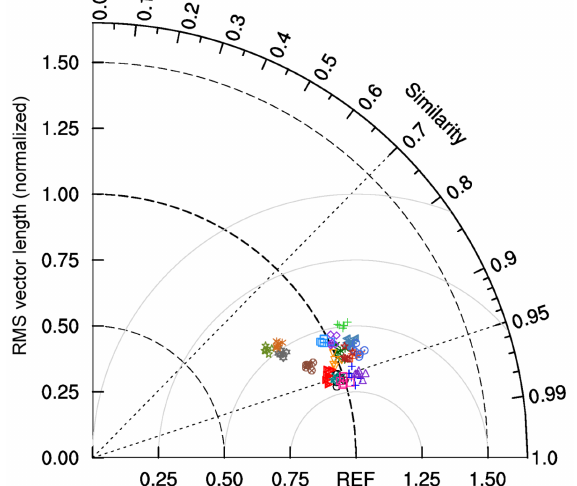
Figure 8. Normalized pattern statistics for climatological mean 850hPa vector winds over the Asian–Australian monsoon region (10 ◦ S–40 ◦ N, 40–140 ◦ E) in summer (June–July–August) derived from each independent ensemble member by models 12, 13, and 14. The datasets used and regridding method are the same as those in Fig. 6, except only three models are included here. Models 12, 13, and 14 include 5, 6, and 9 ensemble simulations which are obtained from CMIP5 historical experiments during the period from 1979 to 2005, respectively. The same type of symbols show a close cluster- ing, and different types of symbols are clearly separated from each other, which suggests that the differences between different models are likely to be significant.